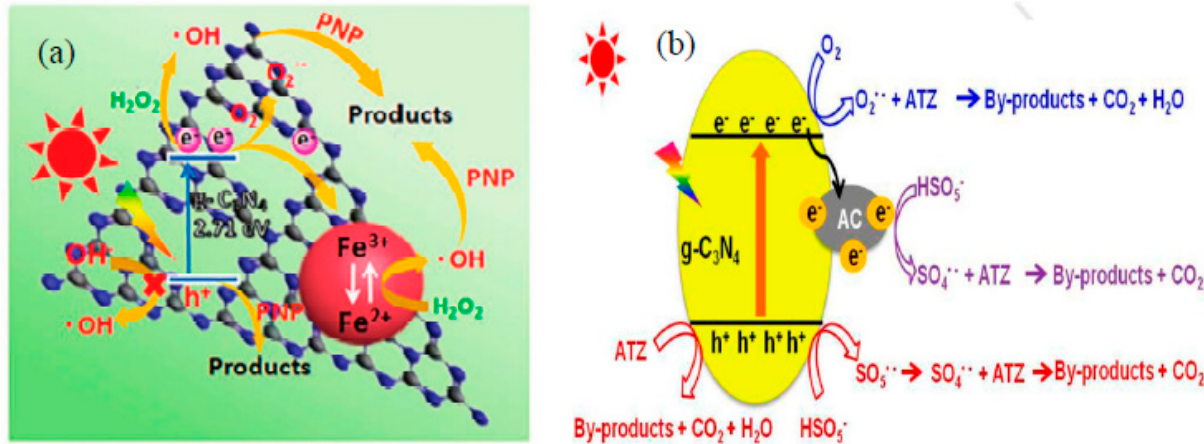
Figure 2. ( a ) schematic illustration of the catalytic mechanism of Fe 2 O 3 QDs/g-C 3 N 4 -900 in H 2 O 2 /vis system, reprinted with permission from [113]. Copyright 2019 John Wiley & Sons, Inc. ( b ) Mechanism of photocatalytic degradation of atrazine with PMS, reprinted with permission from [96]. Copyright 2018 Elsevier.